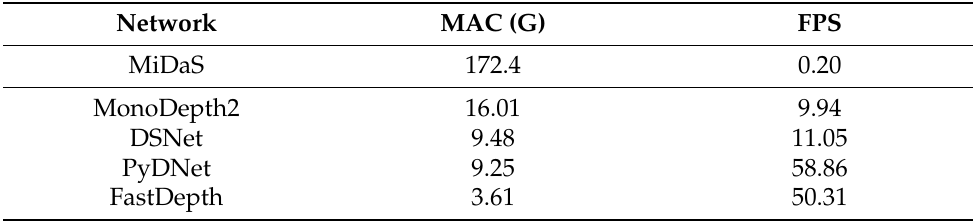
Table 3. Performance on smartphones. We measure both the number of multiply–accumulate operations (MAC) and the FPS of monocular networks on an iPhone XS, using an input size of 640 × 384, averaged on 50 inferences.